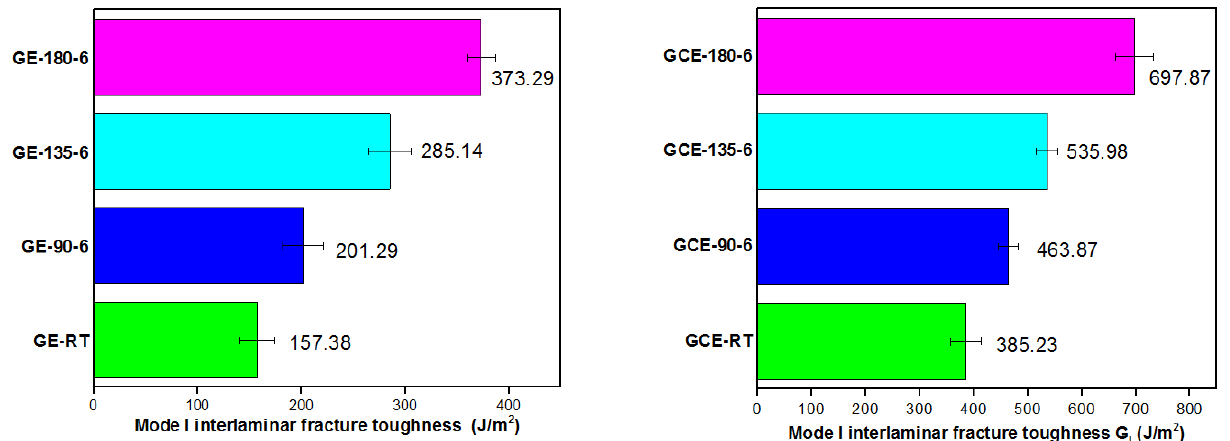
Figure 11. Mode-I interlaminar fracture toughness G I of GE laminates (Left) and GCE laminates (Right).